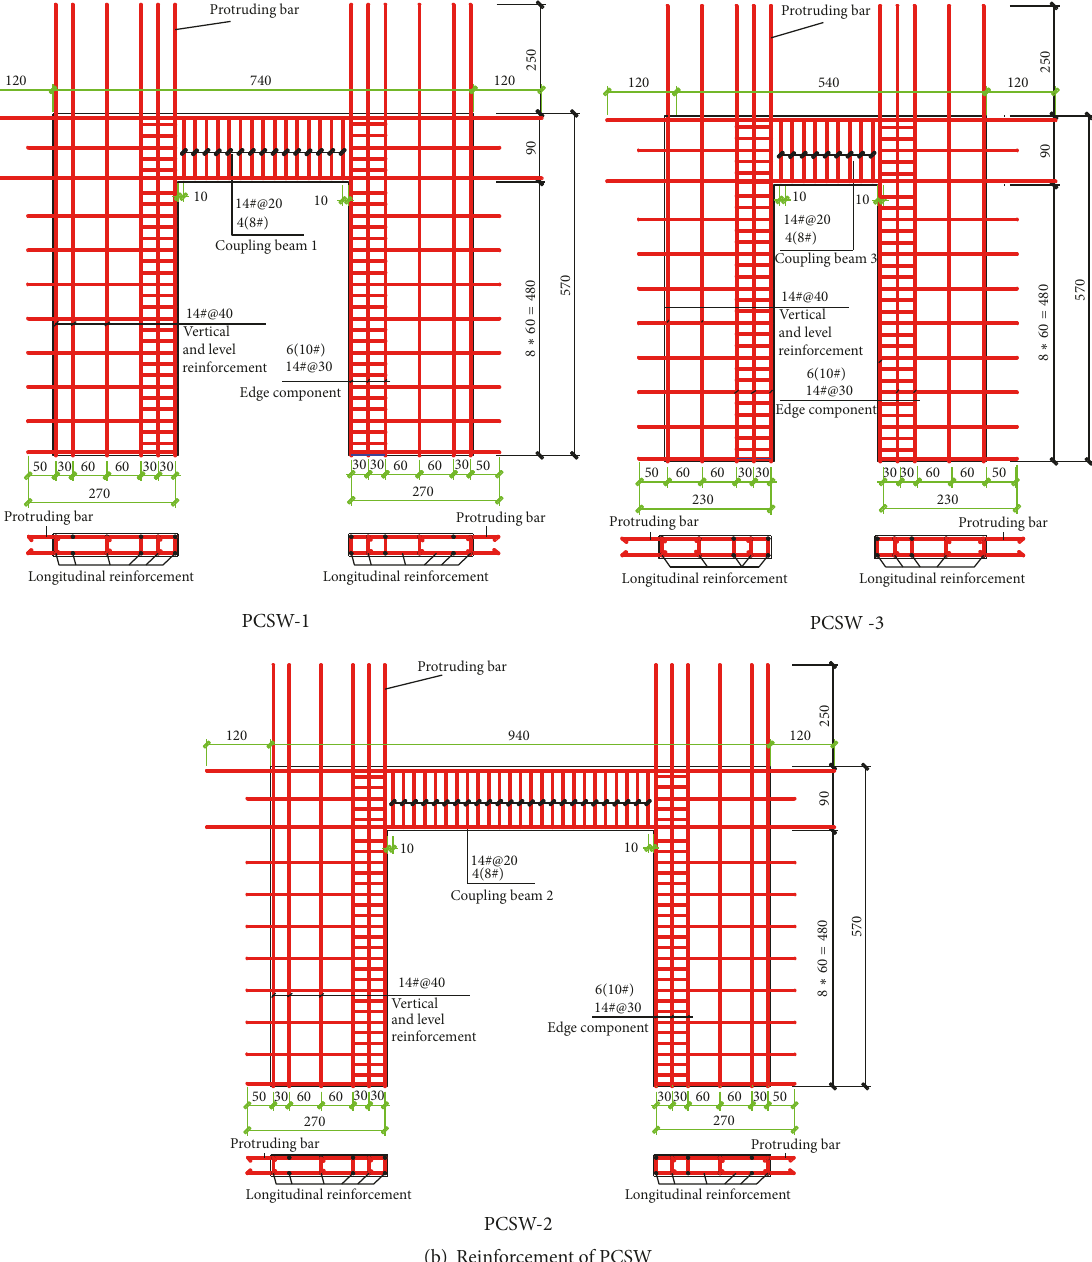
Figure 2: Configuration and reinforcements of the components (unit: